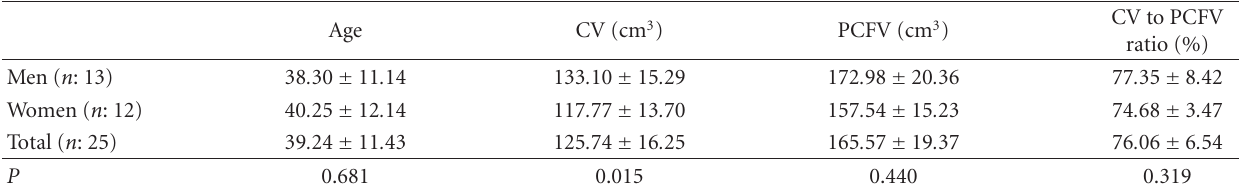
Table 2: Mean ( ± SD) age, CV, PCFV, and CV to PCFV ratio for both sexes in the control group.